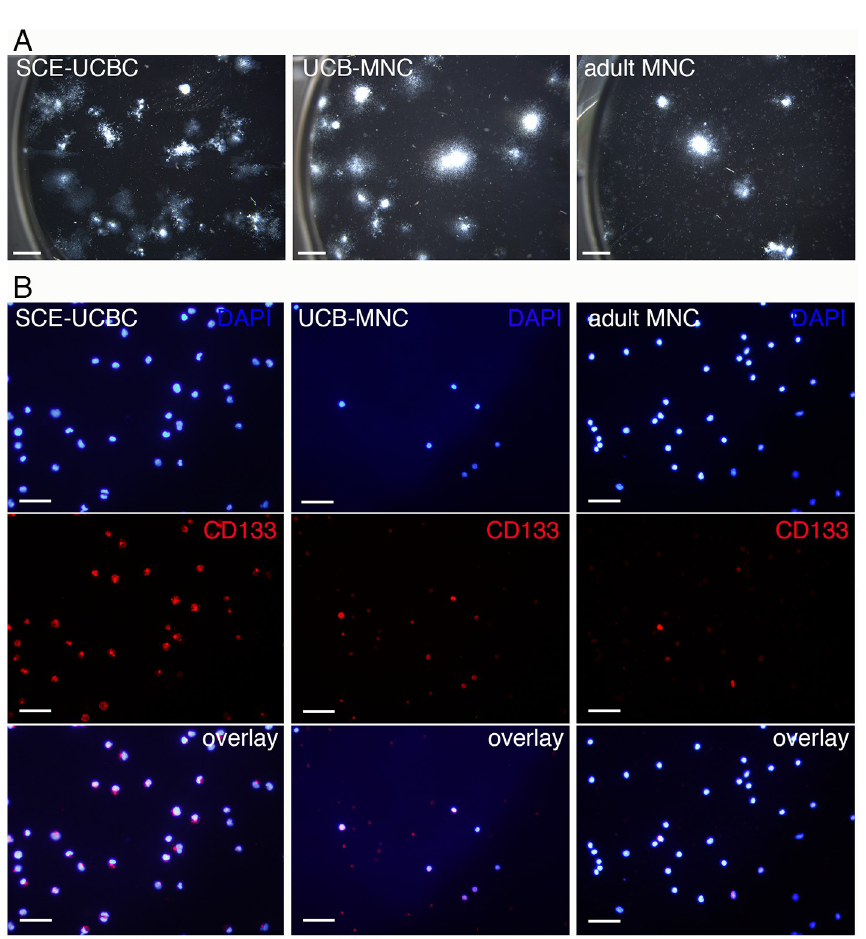
Fig 4. Colony-forming cell assay and CD133 immunostaining of SCE-UCBC, UCB-MNC, and adult MNC. (A) Representative photographs of a CFU-GM assay of SCE-UCBCs, UCB-MNCs, and adult MNCs. Note that the number of seeded cells was different (250 cells/well for SCE-UCBCs, 1x 10 4 cells/well for UCB-MNCs, and 1 x 10 5 cells/well for adult MNCs, see Methods). Bar, 2 mm. (B) Representative photomicrographs of immunostaining against CD133 antibody. Upper panel; DAPI, middle panel, CD133, lower panel, overlay. Bar, 50 μ